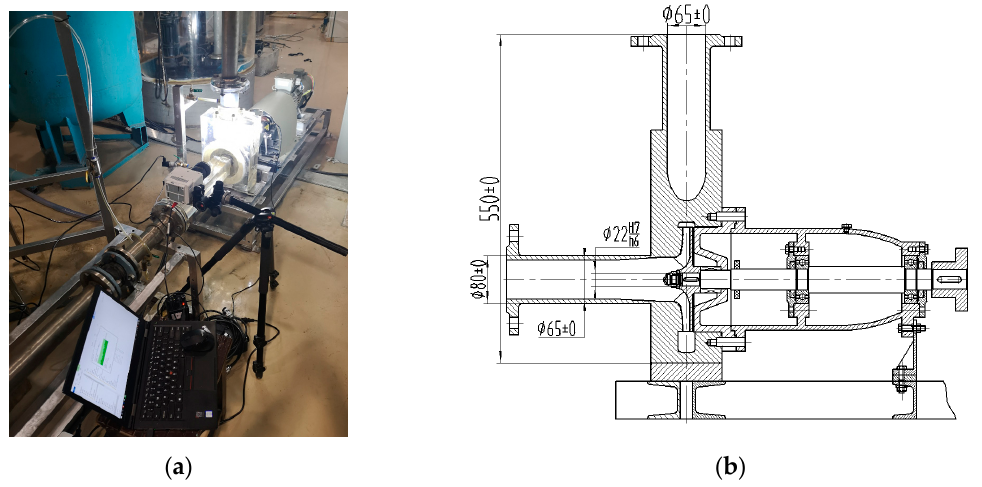
Figure 2. Views of the experimental set up and the transparent pump model. ( a ) Test scene and ( b ) drawing of the pump assembly dimensions (mm).